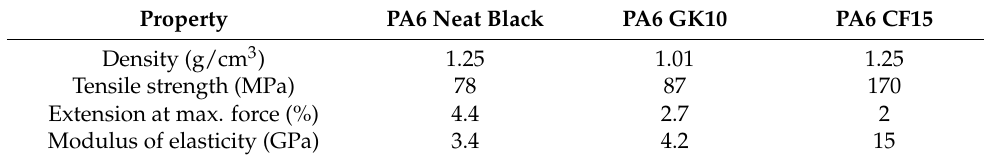
Table 1. Properties of used materials [38].